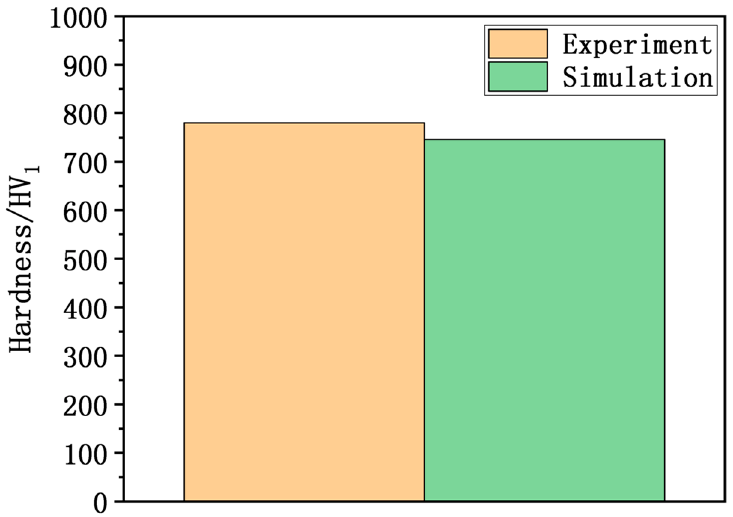
Figure 11. Comparison of simulated and experimental surface hardness.